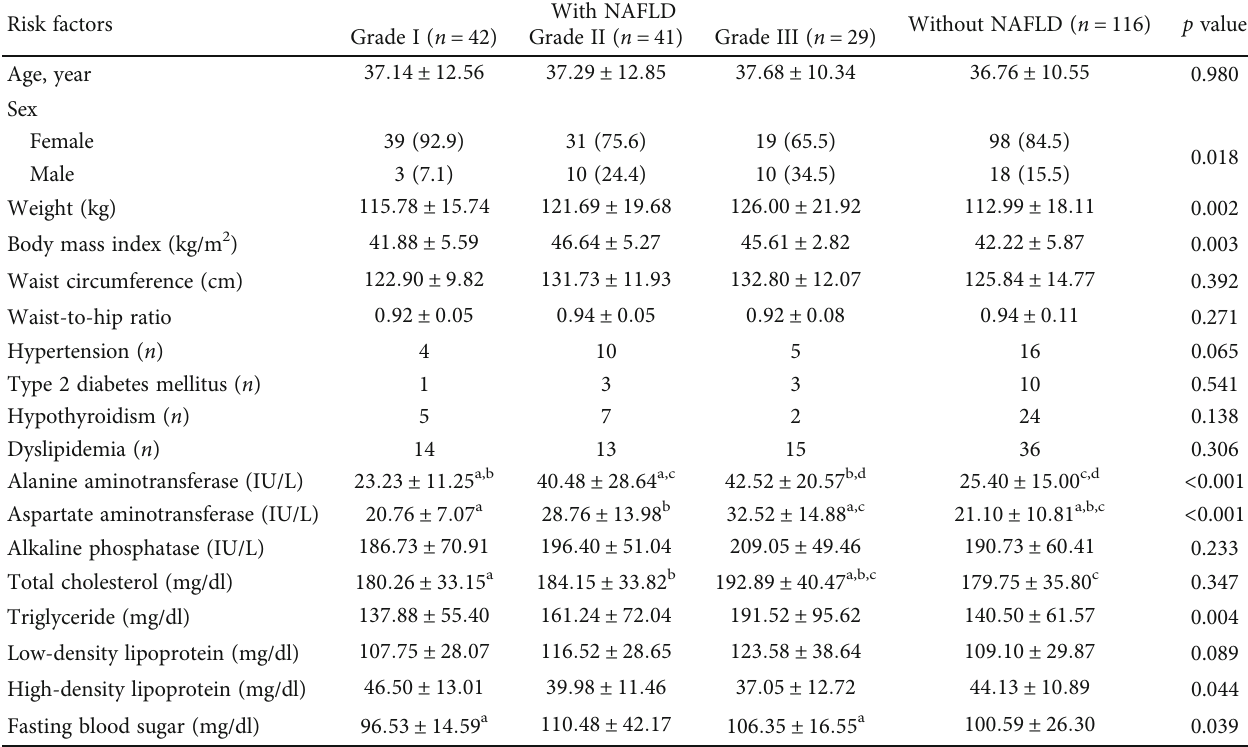
Table 3: Analysis of the clinical and biochemical risk factors of